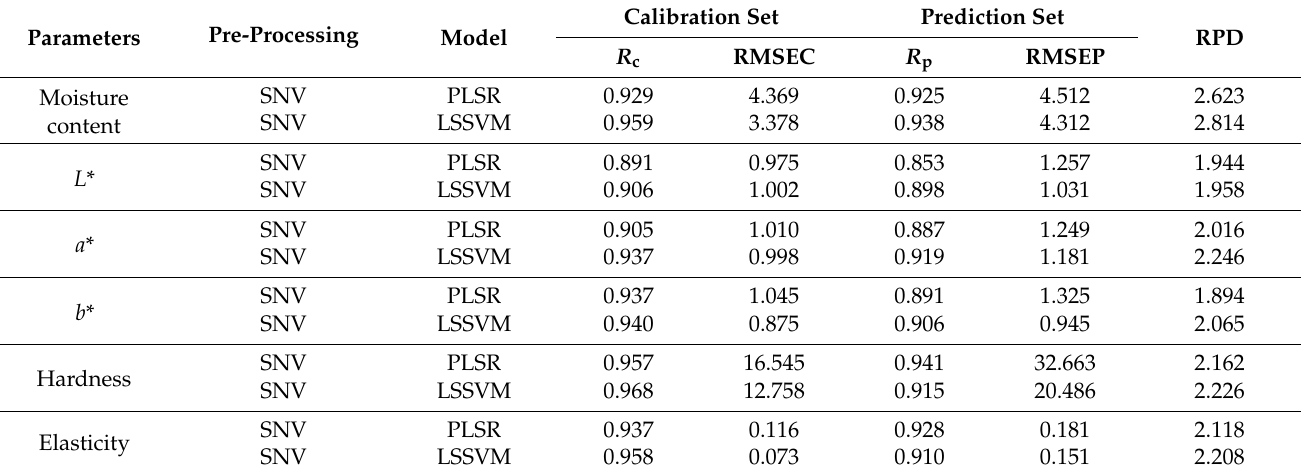
Table 3. Prediction models for moisture content, L *, a *, b *, hardness, and elasticity values using 224